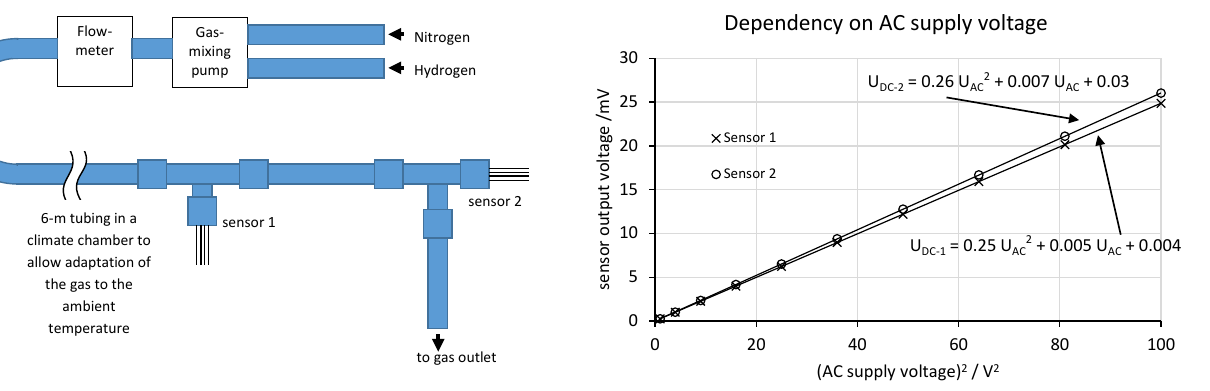
Figure 3. Drawing of the gas tubing with the thermopiles. The sen- sors are fitted in T-junctions within stainless steel tubing inside a climate chamber.